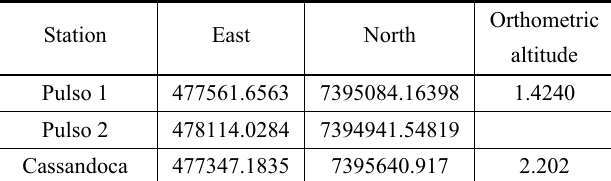
Results of GPS positioning of the Pulso beach on planet Earth. Positioning is given in Universal Topographic Units (UTM) expressed in meters, which have reference in the meridian of 45 ◦ W and latitude 0 degrees. – UTM System of Coordinates